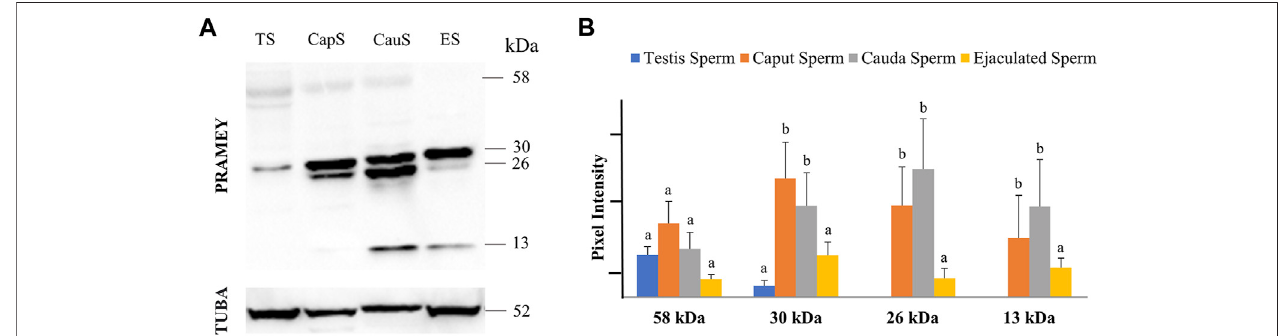
FIGURE 1 | Expression of PRAMEY isoforms in bovine spermatozoa collected from testis (TS), caput (CapS), and cauda (CauS) segments of the epididymis and ejaculated spermatozoa (ES). (A) Immunoblot of total sperm protein in each group probed by PRAMEY antibody and then reprobed by α -tubulin (TUBA) antibody. (B) Quanti fi cation of pixelintensities for the58, 30, 26, and 13 kDaPRAMEY bands, normalized tothe correspondingTUBA. Dataare expressed asthe mean ofthe protein pixel intensity ±SEM ( n = 5). Signi fi cance was evaluated between the four types of sperm (testis, caput, cauda, ejaculated) for each PRAMEY isoform (58, 30, 26, and 13 kDa). Values without a common superscript differed ( p <